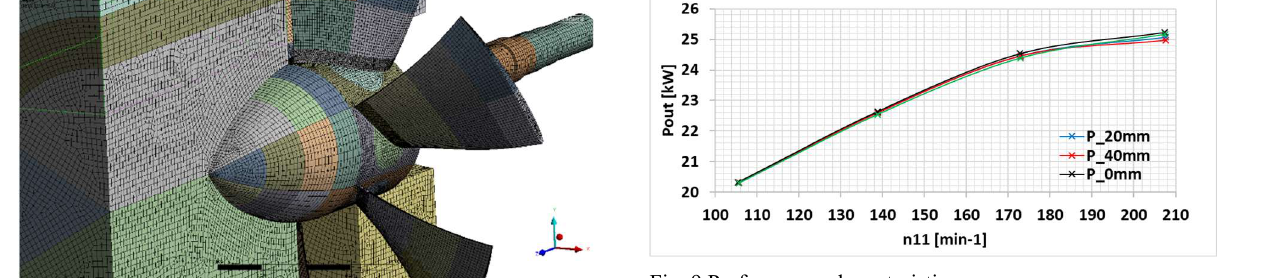
Fig. 9 Performance characteristics The amplitude-frequency characteristics